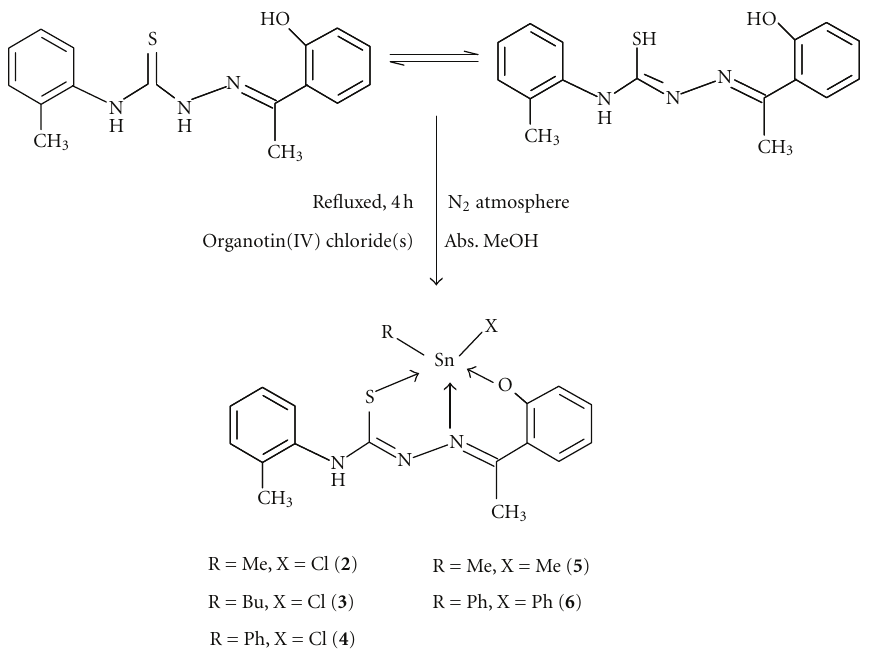
Scheme 2: Reaction scheme for the synthesis of organotin(IV) complexes ( 2–6